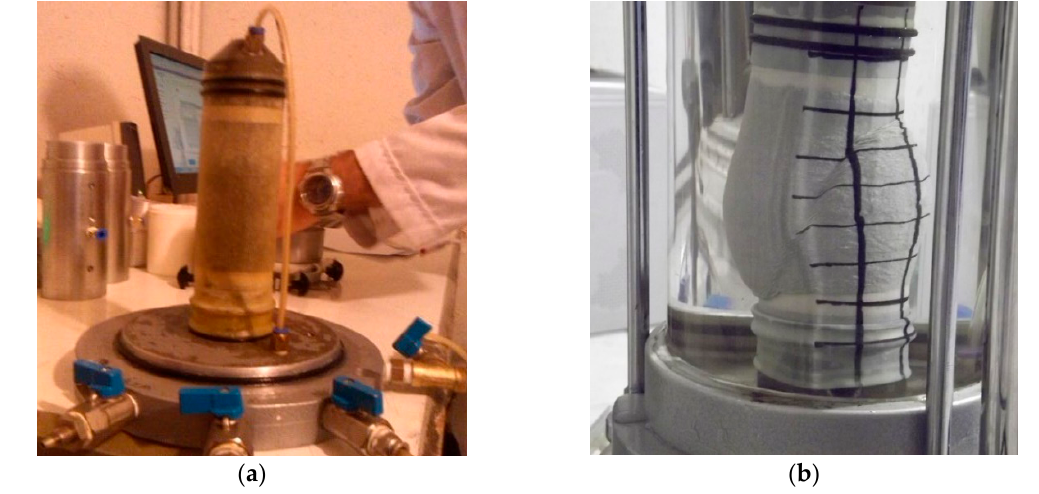
Figure 6. Examples of ( a ) preparation and ( b ) tested triaxial sample.